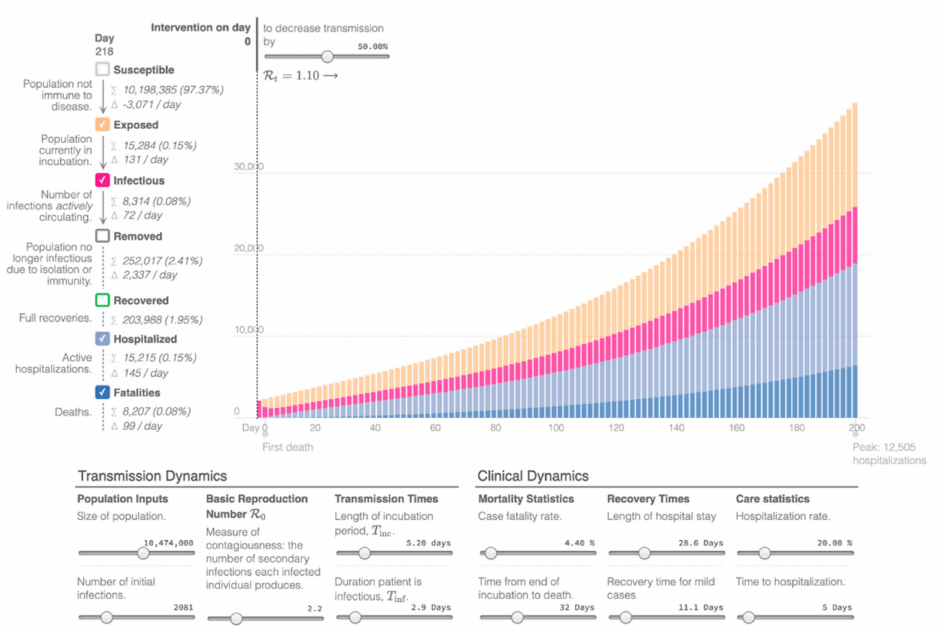
Figure 2. Epidemiological Curve 2.